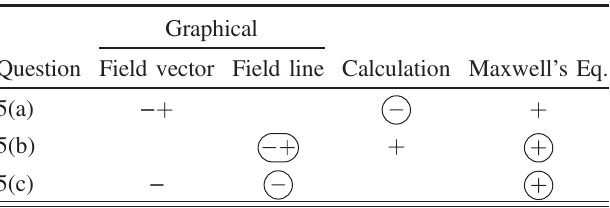
TABLE IV. Analysis of answers given by student C regarding the curl of magnetic fields [questions 5(a) – 5(c)].